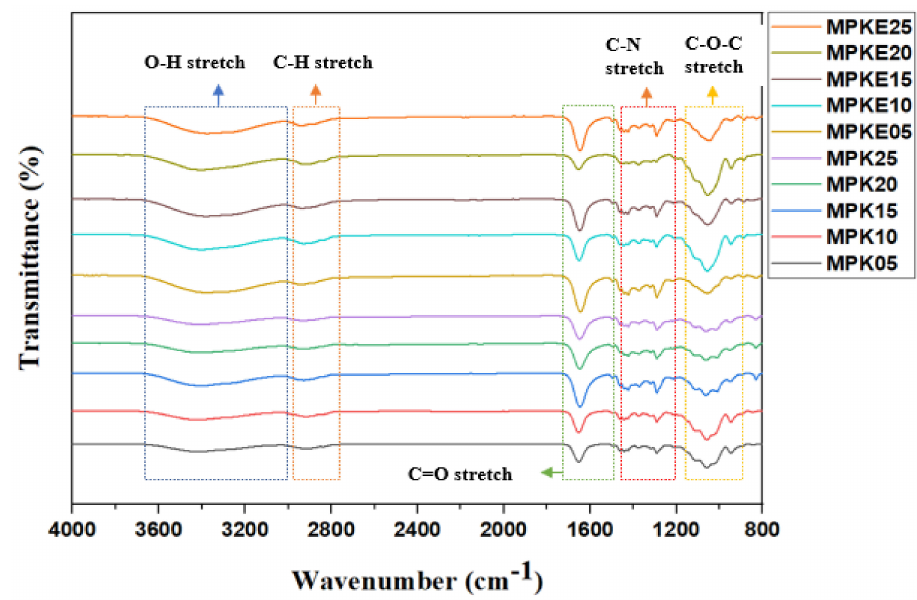
Figure 4. FTIR of plasticized and non-plasticized MC/PVP/K 2 CO 3 SPEs.